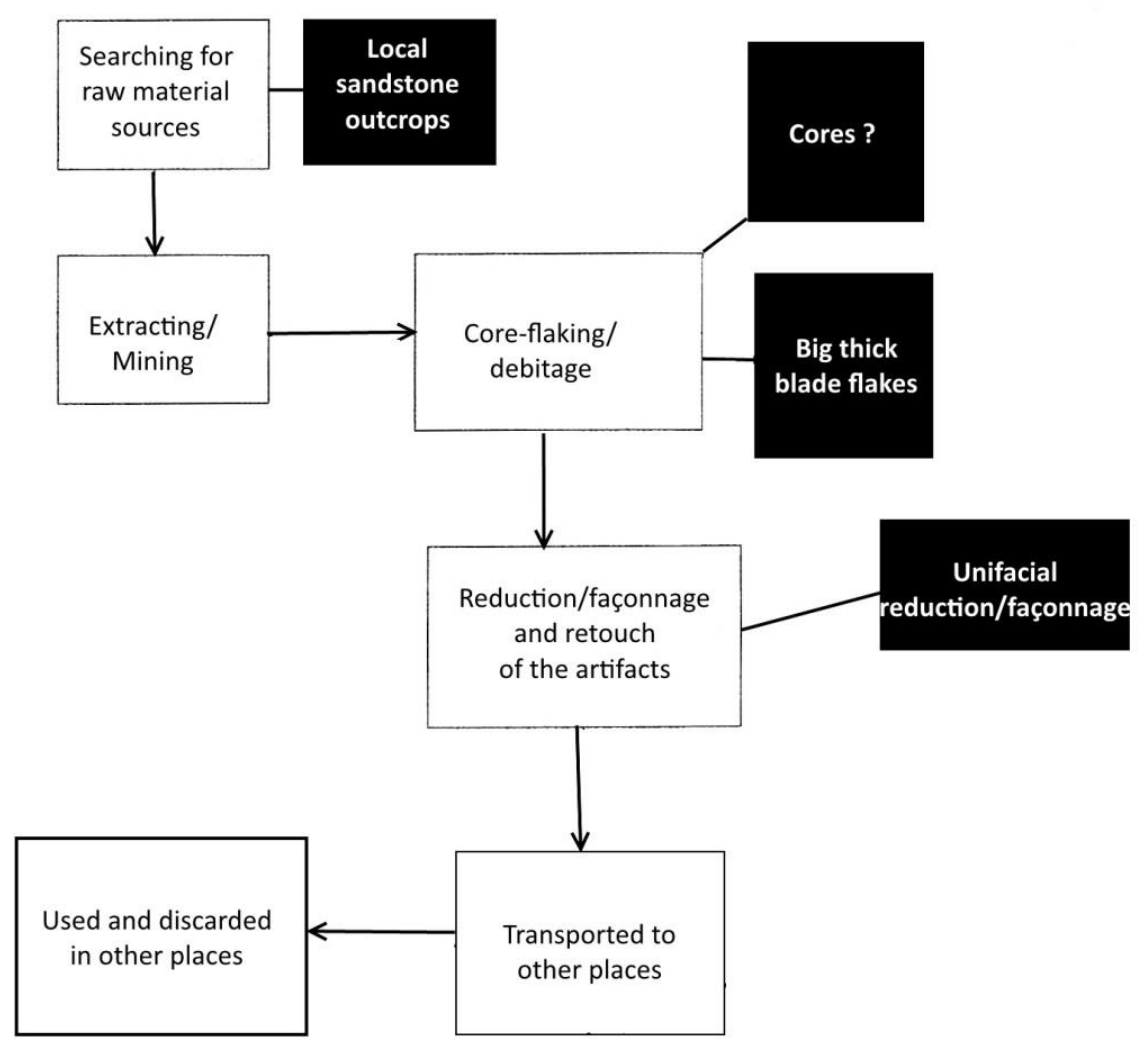
Figure 3. Operatory chain of lithic artifacts of Gruta das Araras site. White boxes represent different stages. Black boxes represent the analysed